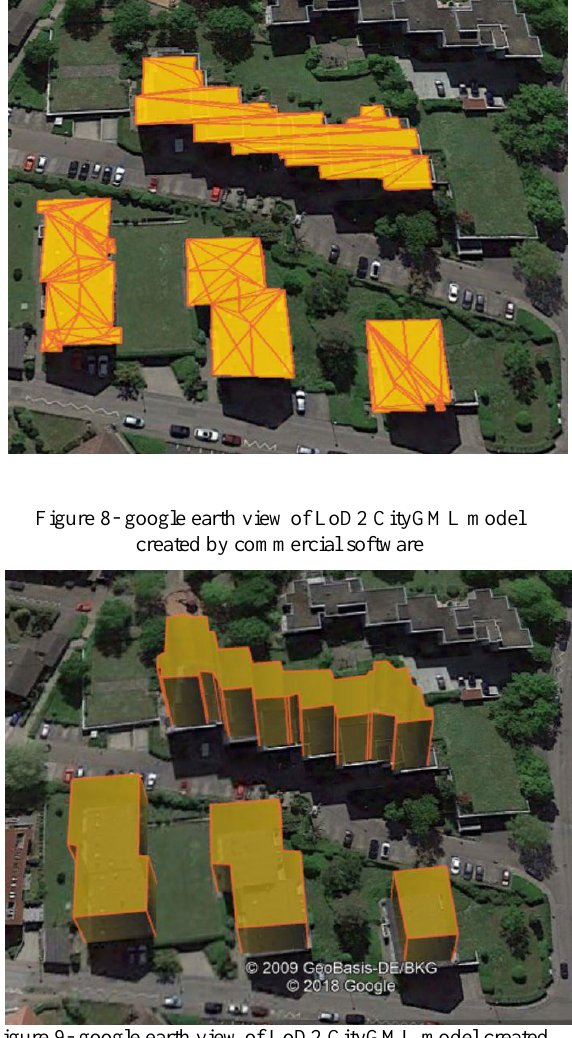
Figure 9- google earth view of LoD2 CityGML model created by open source